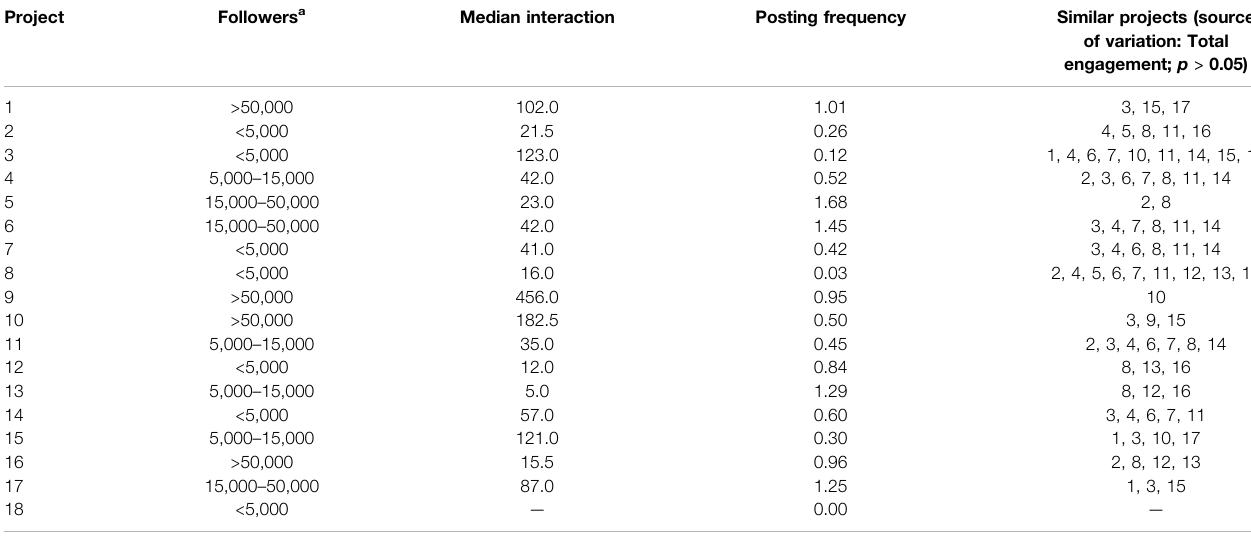
TABLE 2 | Citizen science projects selected for a more thorough analysis and their respective Facebook following, posting frequency and median interaction obtained by each post. The last column exhibits projects with statistically similar engagement values ( p > 0.05), which was achieved by running a Kruskal-Wallis test (H 16 (cid:1) 613.916; p < 0.001) followed by Dunn ’ s